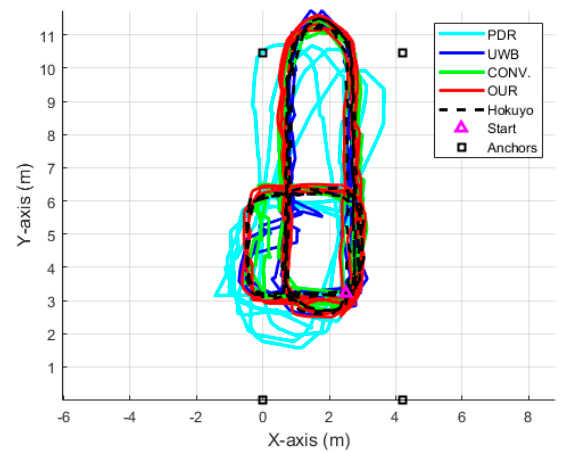
Figure 15. Position trajectory of each algorithm in multi-lap LOS+NLOS scenario.